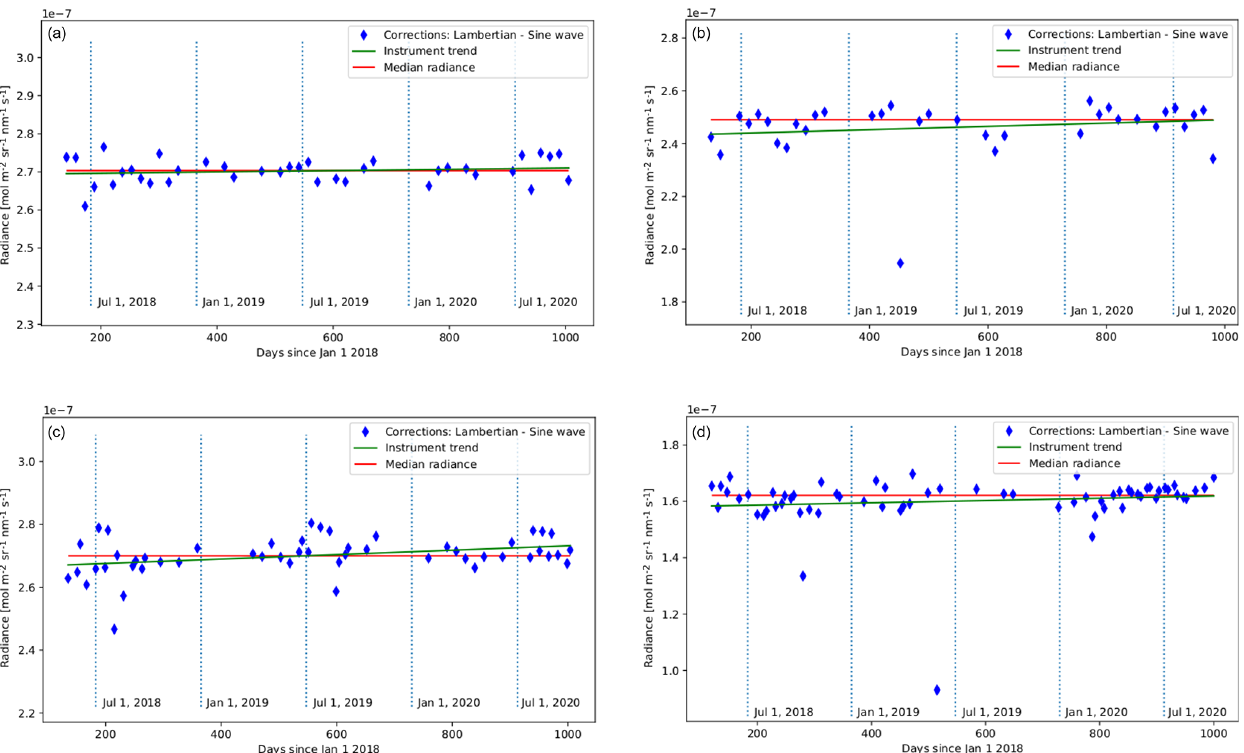
Figure 6. Continuum radiance of Egypt1 (a) , Algeria3 (b) , Libya3 (c) and NamibiaPICSAND1 (c) using a zenith angle filter of 7.5 ◦ . Shown are all soundings over a period of more than 1000d, starting 28 April 2018. The median radiance (red) and a linear fit (green) are shown with lines. Data have been corrected for the solar zenith angle at each individual overpass and assuming the surface is Lambertian. A yearly variation has been corrected using a fitted sine wave with a period of 365d. Other sites are given in the